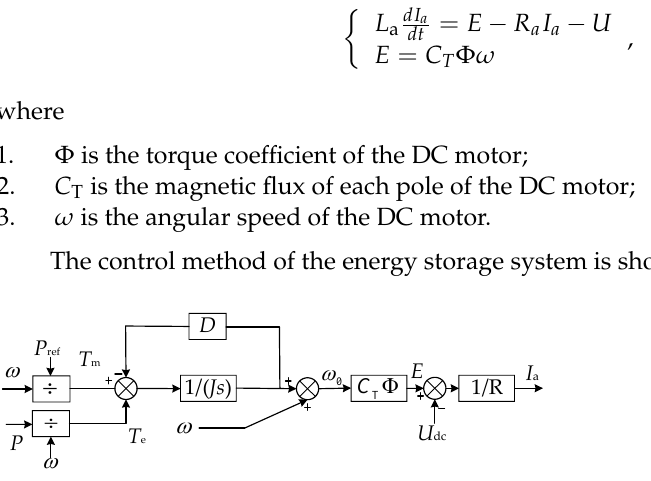
Figure 15. Control block diagram of VDCM.